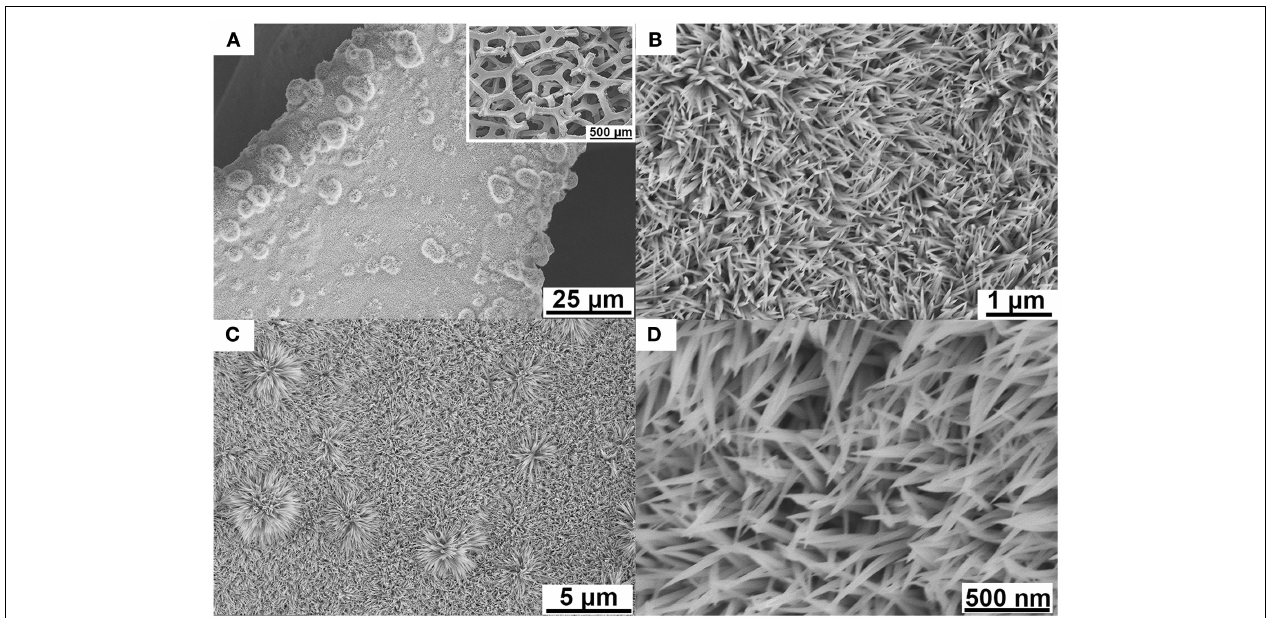
FIGURE 1 | SEM images (A) Ni–Co–Mn hydroxide nanoneedles grown on Ni foam, at low magnification (the inset shows the nanoneedles on Ni foam at a large scale) . (B) Precursor hydroxide nanoneedles at higher magnification. (C) Ni–Co–Mn oxide on Ni foam after annealing. (D) High-resolution SEM image of Ni–Co–Mn oxide nanoneedles with ultra-sharp tips.